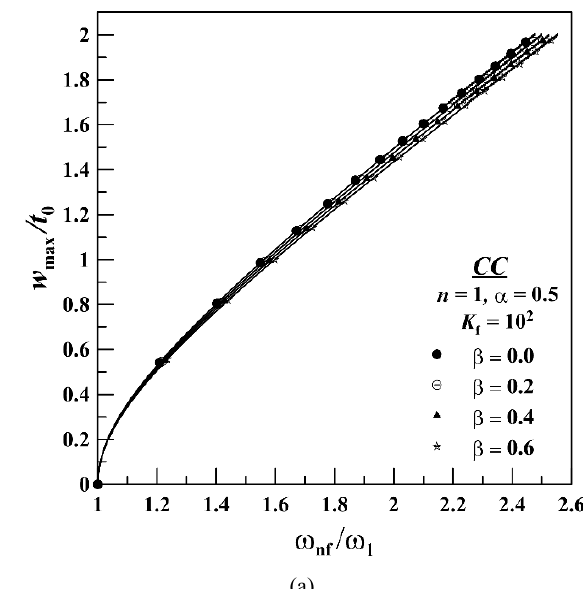
Figure 2. Backbone curves for different values of root foundation stiffness for (a) CC beam, (b) CS beam, (c) SS